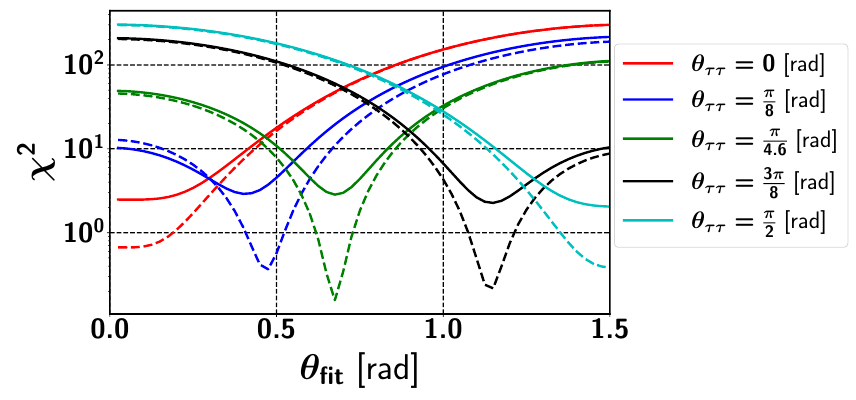
Figure 6 . Absolute value of the χ 2 for the five different values of CP-mixing θ ττ evaluated according to eq. (4.3) with δ = 0 . 5% · ( N ) . The solid and dashed lines correspond to the 2K (HL- sys bkg /N bins LHC) and 2M (”infinite statistics”) event samples, respectively, for details see